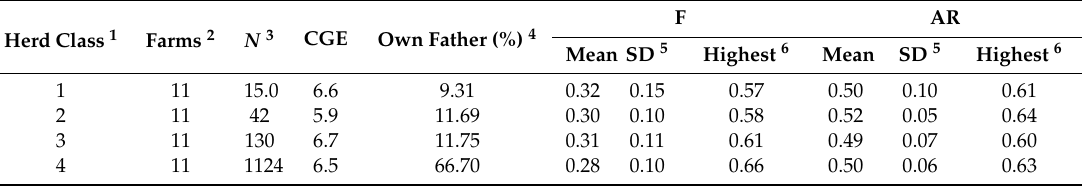
Table 5. Population structure, average inbreeding (F) and relationship coefficients (AR) among animals born in different herd size percentile class.